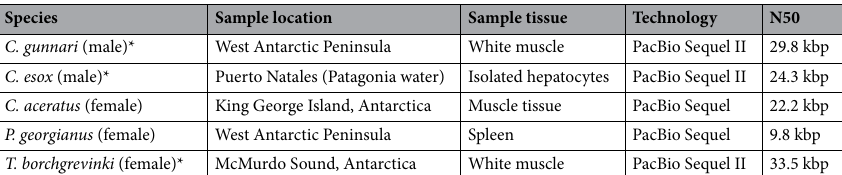
Table 2. Sample information, sequencing technology and N50 raw read length for species sequenced in this study. The * refers to the mt genomes assembled by the PacBio reads generated in our study. For C. aceratus 96 and P. georgianus 97 , we downloaded the available PacBio reads and assembled the mt